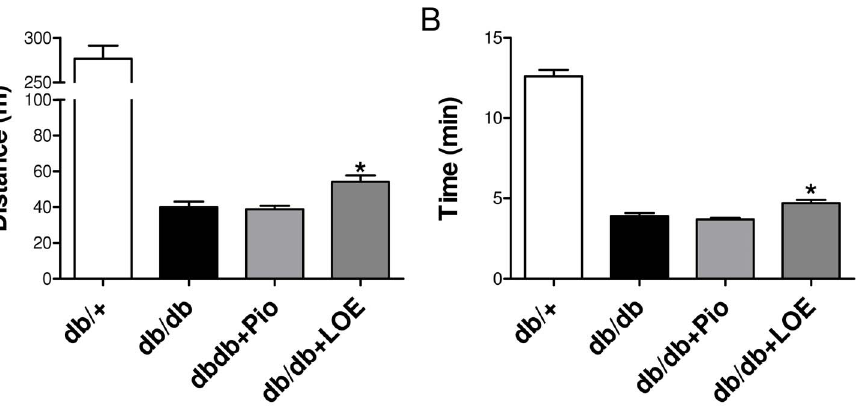
Figure 7. LOE but not pioglitazone improves slightly but significantly the physical exercise capacity of db/db mice. The physical performance was assessed using a treadmill. (A) Time to exhaustion, (B) maximal distance run before exhaustion. Values are shown as means 6 S.E.M. (n=13–14). * P , 0.05 indicates a significant difference versus db/db group.